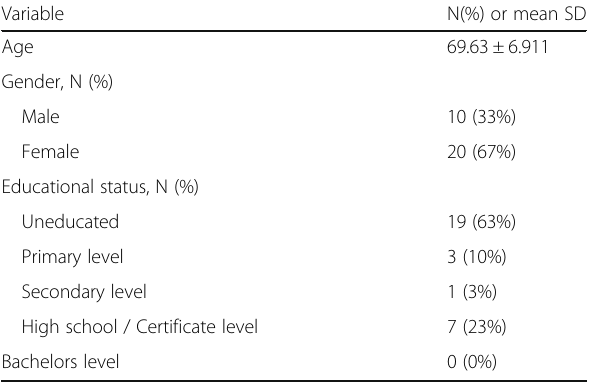
Table 1 Demographic details of participants in testing pre-final version of